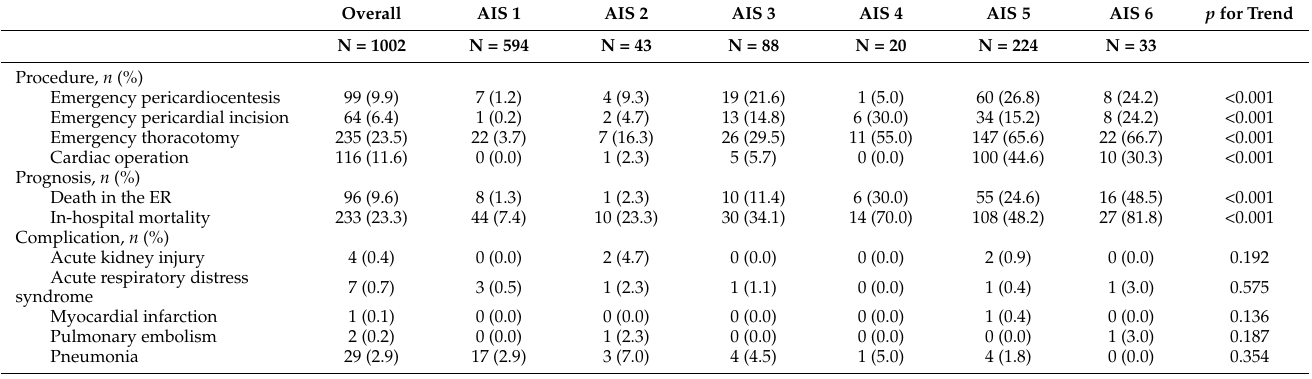
Table 4. Procedures and prognosis following arrival at the hospital among cardiac injury